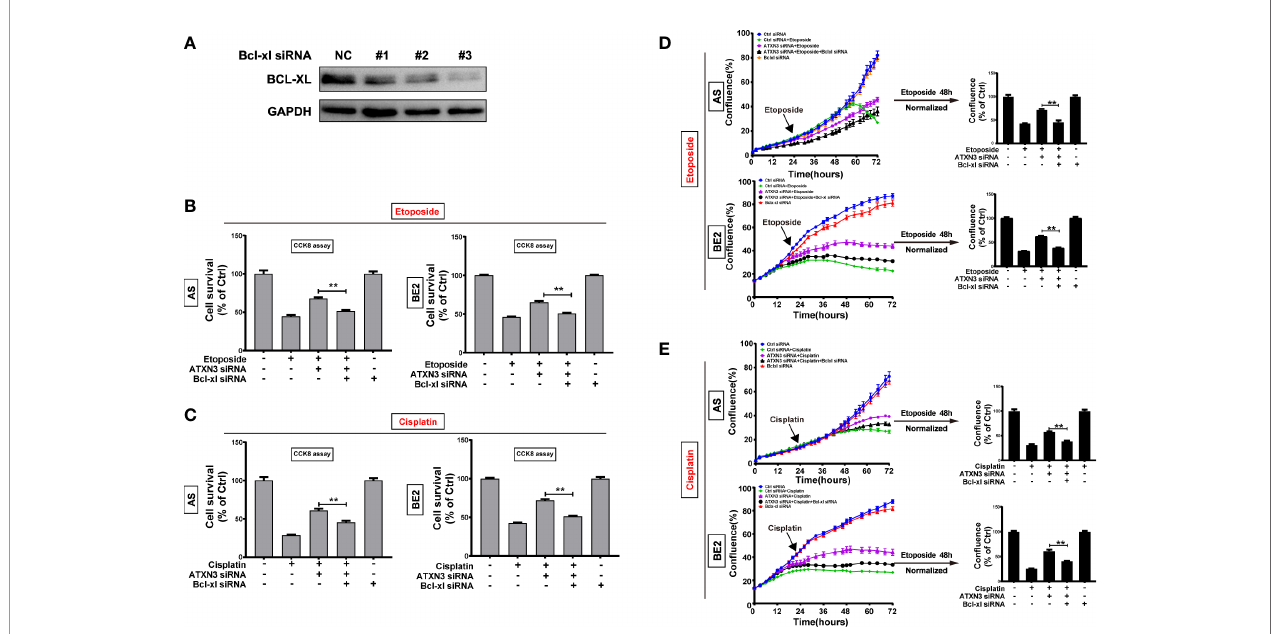
FIGURE 6 | Silencing Bcl-xl attenuated the decrease in sensitivity to etoposide and cisplatin caused by the downregulation of ATXN3. (A) AS and BE2 cells were transfected with Bcl-xl siRNAs (#1, #2, and #3) for 48 h, and the expression of Bcl-xl was detected by western blot; (B, C) Bcl-xl siRNAs#3(marked as Bcl-xl siRNA) and ATXN3 #2(marked as ATXN3 siRNA) were transfected into AS and BE2 cells alone or combination, then the cells were treated with etoposide (AS:1 m g/ml; BE2: 4 m g/ml) or cisplatin (AS:1 m g/ml; BE: 2 m g/ml) for 48 h, cell survival was detected by CCK8 assay; (D, E) the con fl uence of etoposide was detected and analyzed by IncuCyte Zoom. Bar, SD, **P < 0.01, ATXN3 siRNAs + etoposide/cisplatin + Bcl-xl siRNA vs. ATXN3 siRNA +